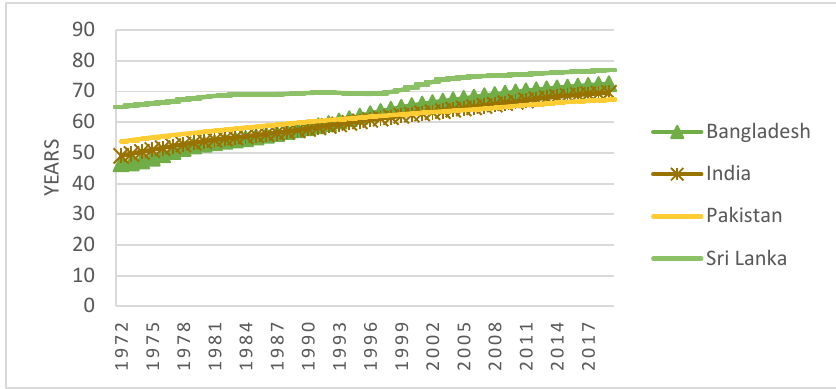
Figure 1. Life Expectancy in Selected South Asian Countries. Source: World Bank [30].